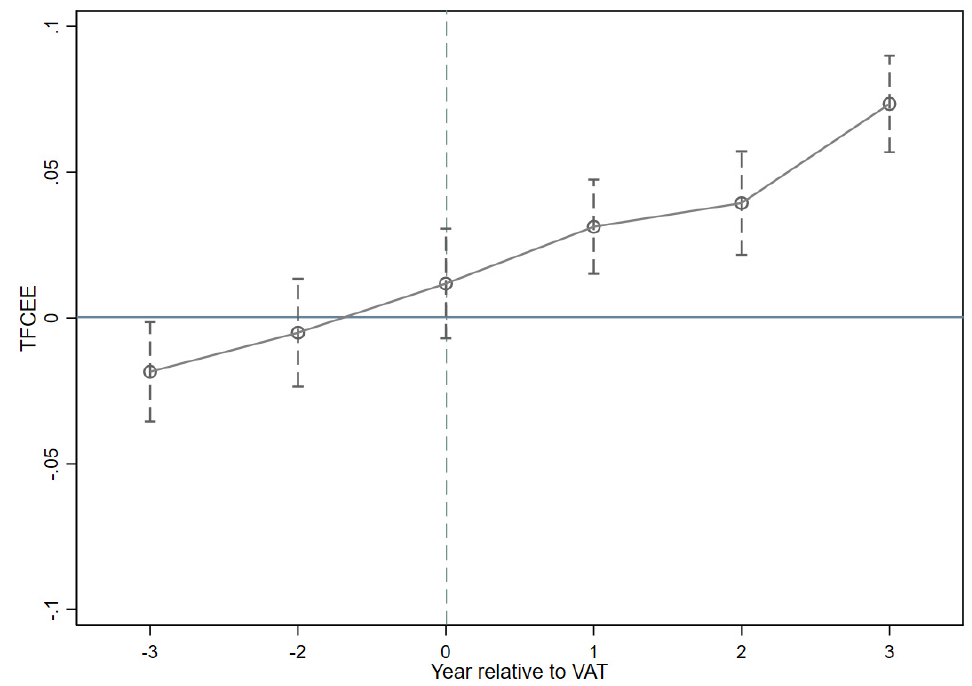
Figure 2. Parallel trend test and the dynamic effect analysis of VAT reform. Notes: The horizontal coordinates indicate the year relative to the reform. Specifically, 0 indicates the year in which the VAT reform took place, and 1 indicates the first year of the VAT reform. The vertical coordinate indicates the size of the dummy variable, with the dashed line depicting the 95% confidence interval. The model also incorporates city and time-fixed effects.